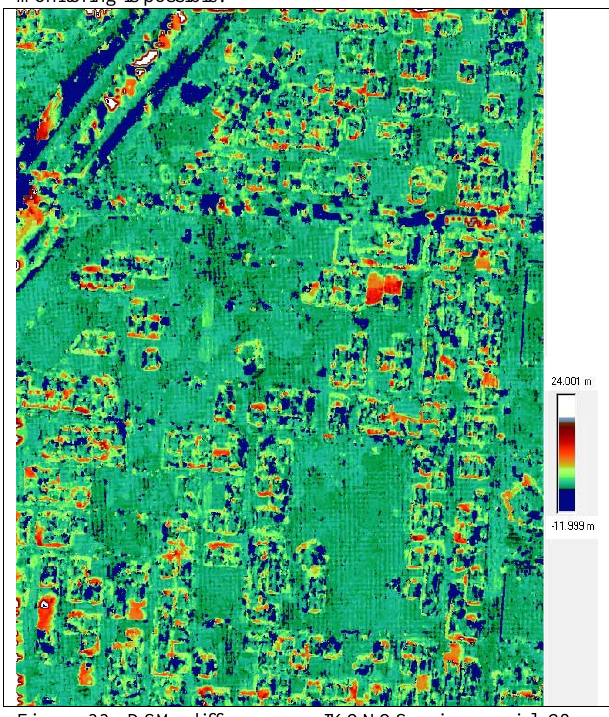
Figure 33: DSM differences – IKONOS minus aerial 28cm GSD, based on LSM